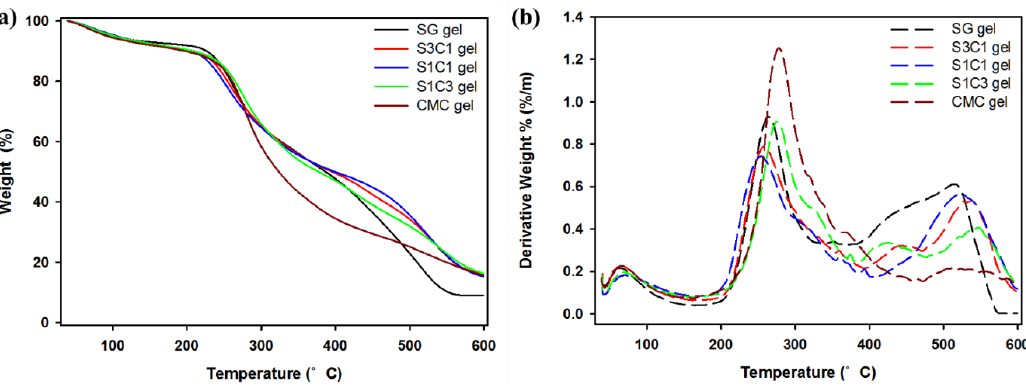
Figure 3. ( a ) TGA and ( b ) DTG curves of SG/CMC IPN gel.